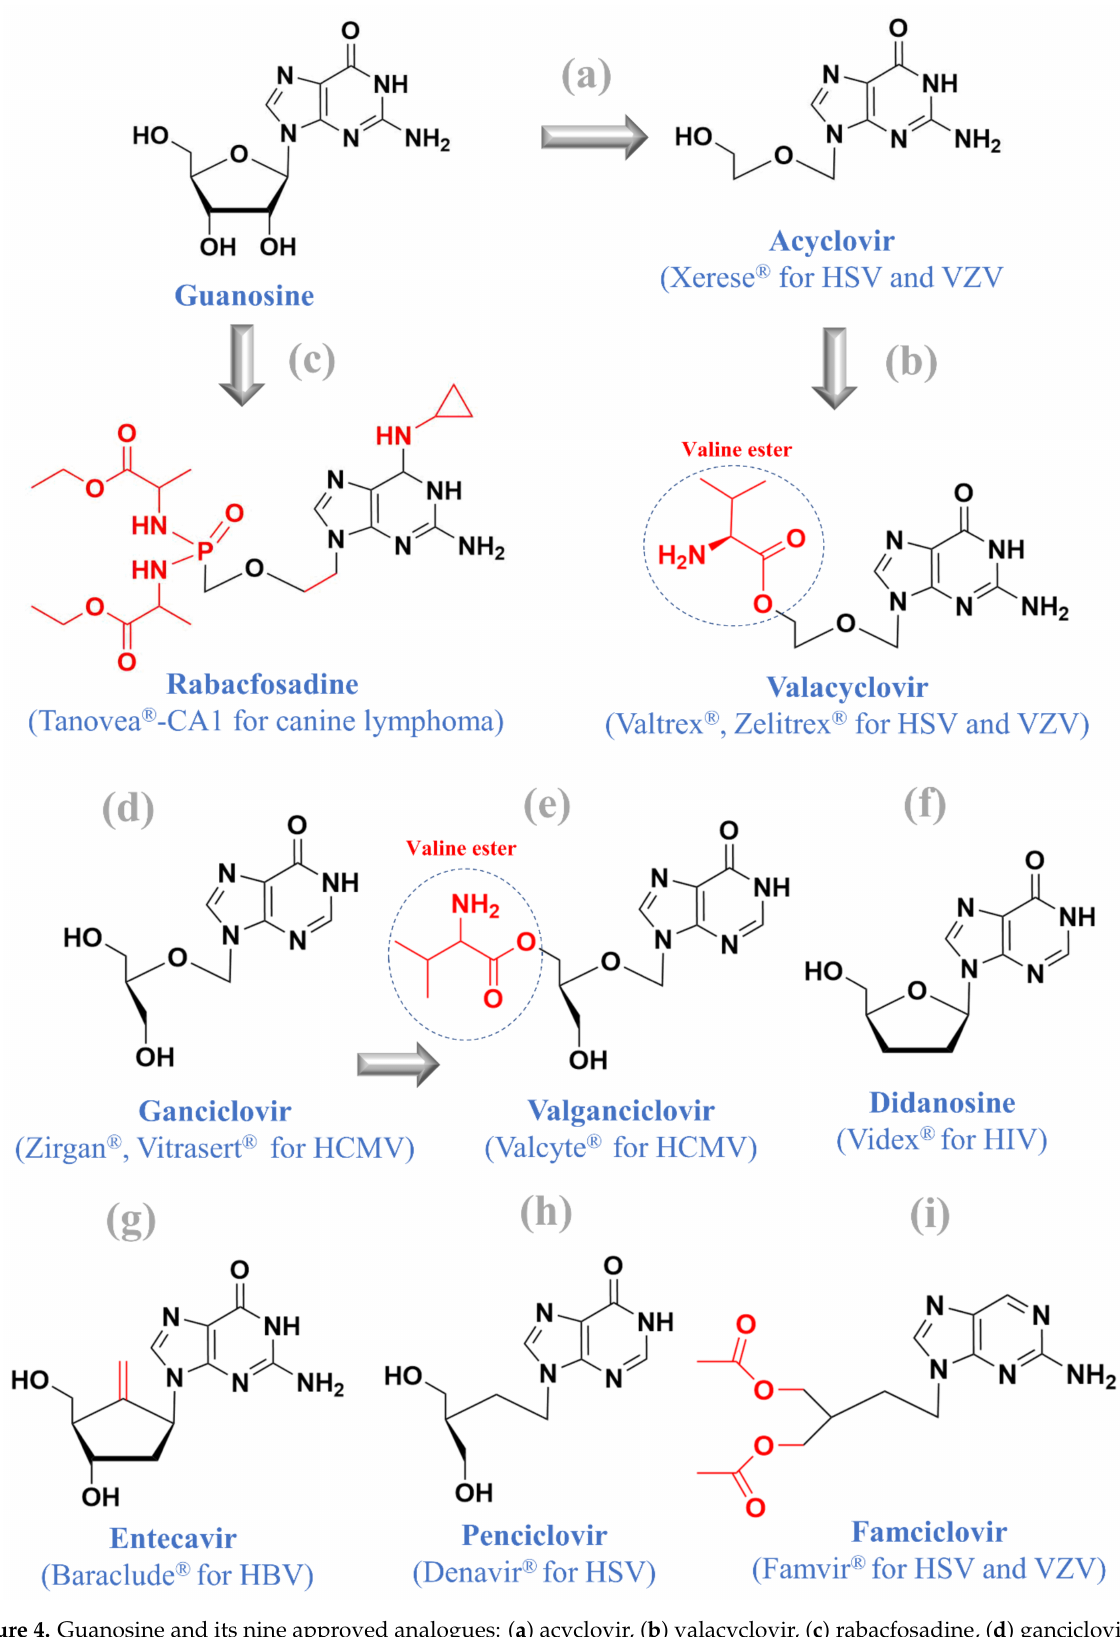
Figure 4. Guanosine and its nine approved analogues: ( a ) acyclovir, ( b ) valacyclovir, ( c ) rabacfosadine, ( d ) ganciclovir, ( e ) valganciclovir, ( f ) didanosine, ( g ) entecavir, ( h ) penciclovir, and ( i )